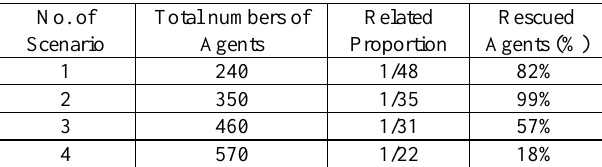
Table 2. Statistics of